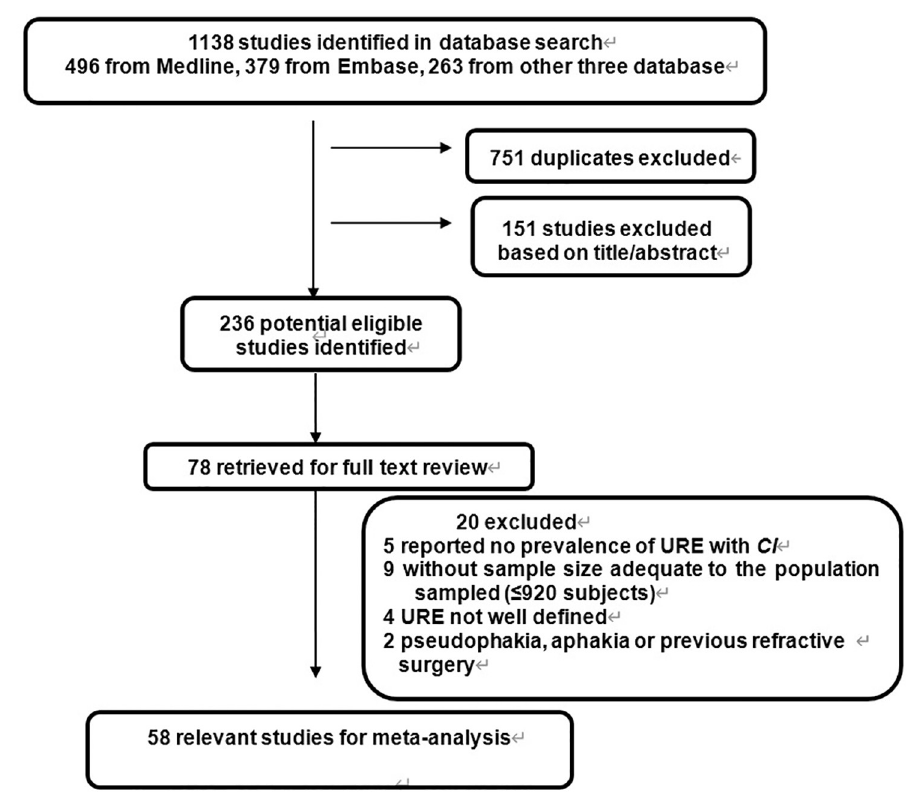
Fig 1. Flow diagram showing the selection process for inclusion of studies in the meta-analysis. CI = confidence interval; URE = uncorrected refractive error.